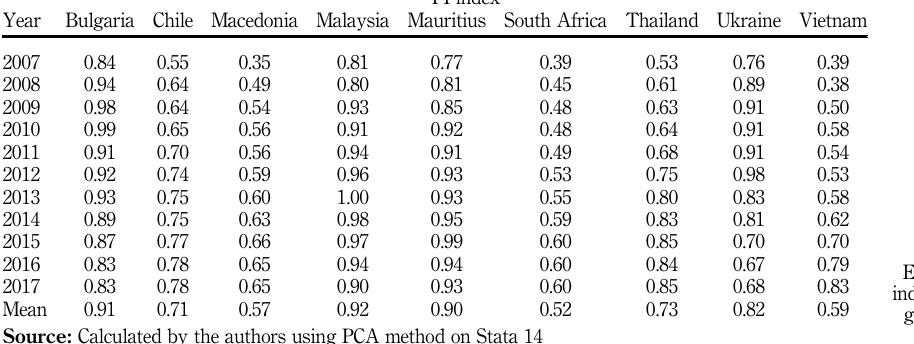
Table II. Estimation of the